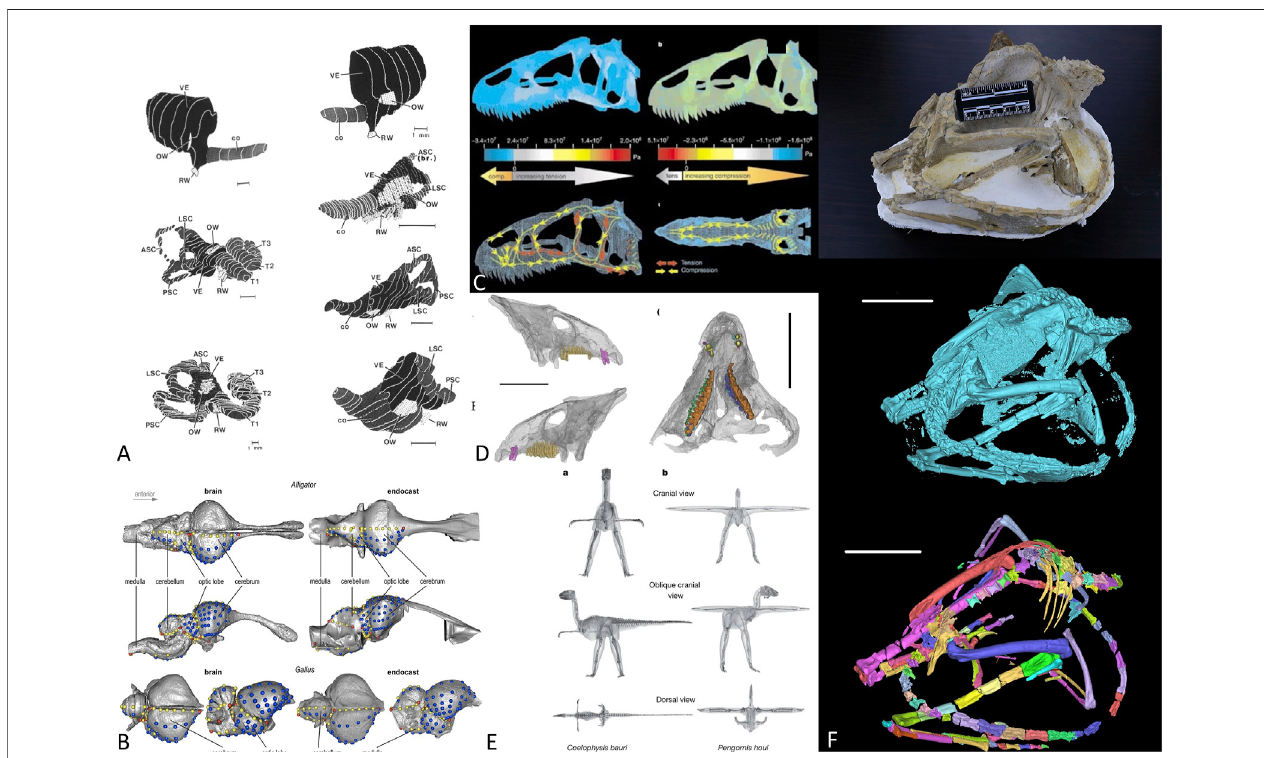
FIGURE 1 | Application of CT scans in vertebrate paleontology. (A) mammal inner ear structure reconstruction, from Luo and Ketten (1991); (B) archosaur brain evolution, from Watanabe et al. (2019); (C) Allosaurus skull mechanic analysis, from Ray fi eld et al. (2001); (D) Tooth replacement in Liaoceratops , from He et al. (2018); (E) dinosaur body mass estimation, from Allen et al. (2013); (F) generalized work fl ow of CT data processing in vertebrate paleontology, from above: original fossils, raw 3D rendering, and segmented bone volumes.